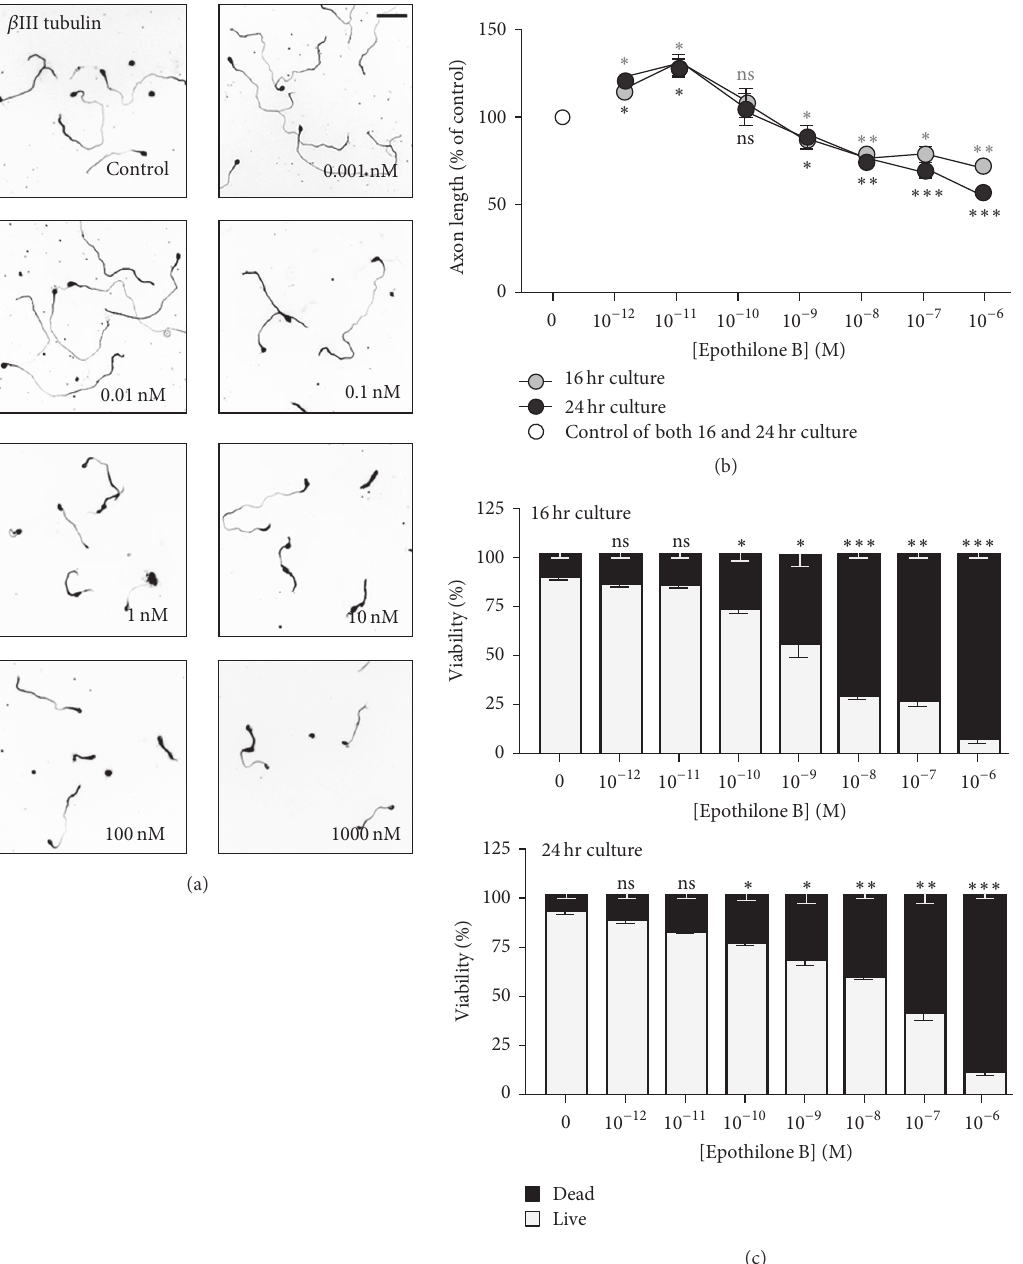
Figure 2: Effects of epothilone B on axon growth and cell viability in embryonic dorsal root ganglion (DRG) neurons. (a–c) Embryonic day 13.5 (E13.5) DRG neurons were plated at a low density and cultured in the absence or presence of various concentrations of epothilone B, from 1pM to 1 𝜇 M, as indicated. Neurons were fixed after overnight culture (fixed at 16 hr or 24 hr after plating) and immunostained with anti-Tuj1 antibodies. Representative images ((a), inverted images from Tuj1 immunostaining (16hr culture) and quantification of axon length (b) are shown (gray, 16hr culture and black, 24 hr culture). Cell viability was assayed by PI staining (c). Scale bar, 100 𝜇 m. ∗ 𝑝 < 0.05, ∗∗ 𝑝 < 0.01, and ∗∗∗ 𝑝 < 0.001; ns, statistically not